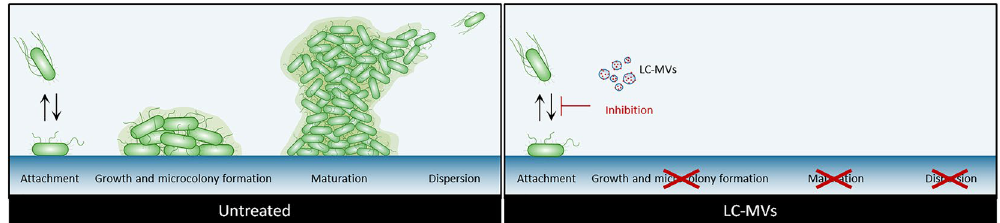
Figure 6. Schematic representation of the effect of LC-MVs treatment on S. Enteritidis biofilm formation. Proteins (in red) associated with LC-MVs inhibit the attachment of S . Enteritidis on polystyrene surfaces, preventing the formation of biofilm. Two peptidoglycan hydrolases (PGHs) were found to be involved in the antibiofilm activity of